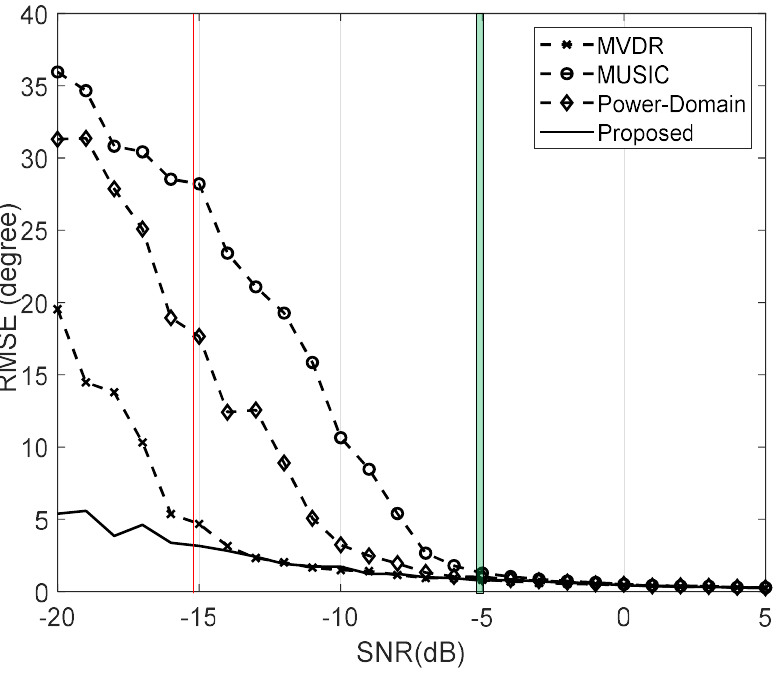
Figure 3. RMSE versus the signal-to-noise ratio (SNR) for the different estimators (MUSIC, MVDR, Power-Domain, and the proposed estimator) in Example 1. Table 1. Direction of arrival (DOA) evaluation for the di ff erent estimators (multiple signal classification (MUSIC), minimum variance distortionless response (MVDR), power domain maximum likelihood (Power-Domain), and the proposed estimator) in Example